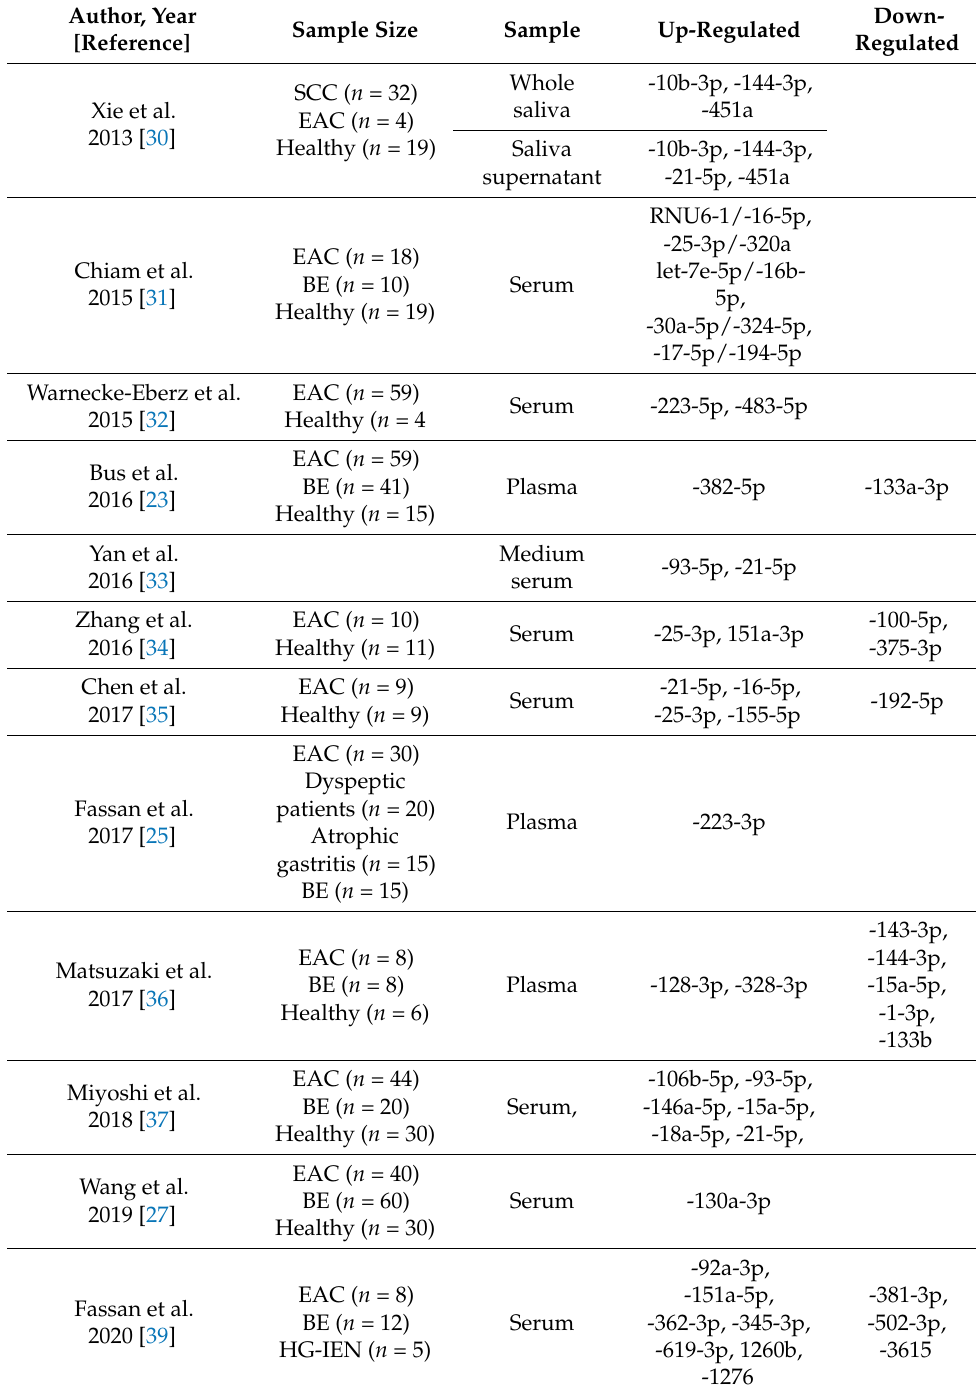
Table 2. MiRNAs used to detect